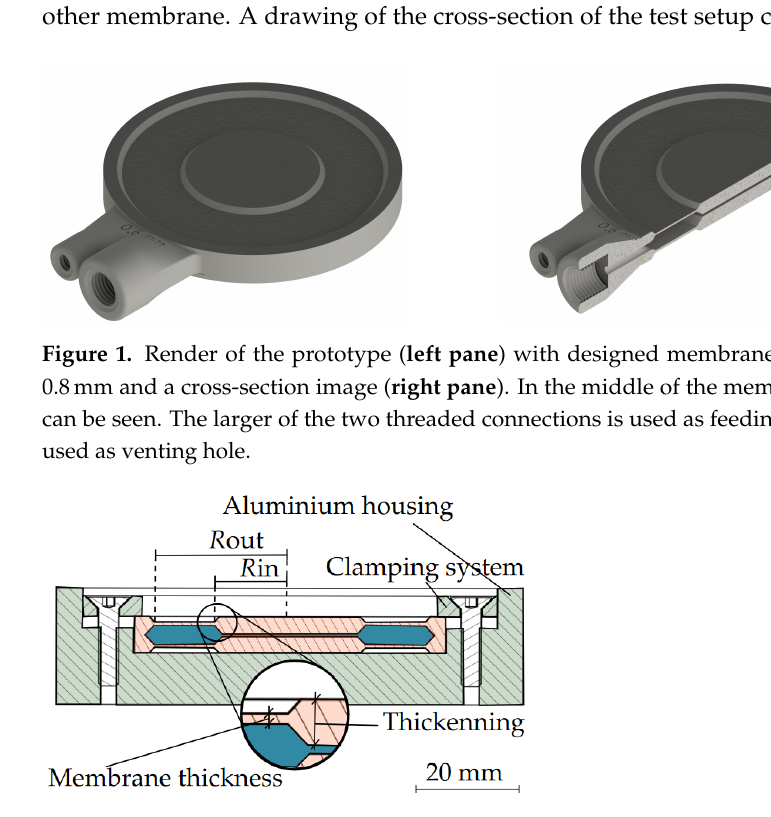
Figure 2. Schematic drawing of the membrane actuator in test setup. R out , the outer radius of the membrane, is 26.0mm. R in , the inner radius of the membrane and the radius of the thickened part, is 14.5mm. The thickening is 2.9mm thick, whereas the membrane thickness ranges between 0.6mm, 0.8mm, 1.0mm up to 1.2mm. An aluminium ring clamps the actuator on the housing. The housing has a radius of 4.5mm and height of 22.5mm. The clamping allows the expansion of the upper membrane and suppresses the expansion of the lower